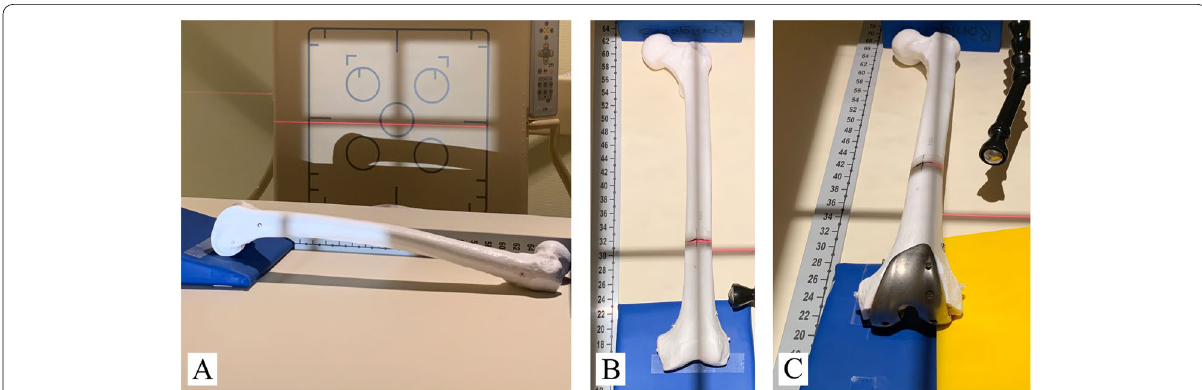
Fig. 1 Experimental setup of radiographic imaging with validation and setup of differenct error conditions. Flexion error validation in true lateral view ( a ). A.p. view preoperative with 5° flexion error ( b ). A.p. view postoperative with internal rotation error ( c ). Laser is used to verify bone position on X‑ray table. Calibration bar and calibration ball for internal validation of distance measurement in PACS software